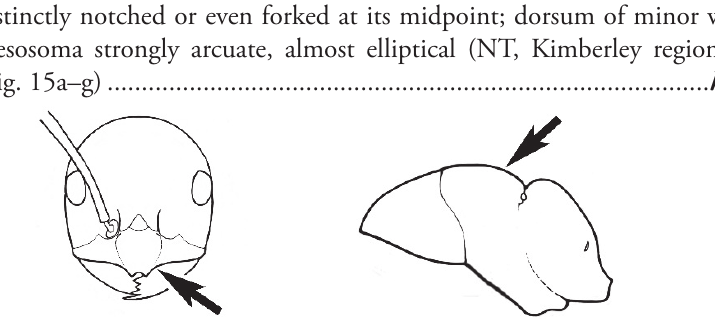
27 In full-face view, anteromedial margin of clypeus produced as a narrow, rectangular flange with a straight or weakly indented edge (otherwise, anatomically identical with M . praesens ) (Pilbara region, WA) ( JDM 1242 ) (Fig. 10a–g) ................................................................................... clypeatus